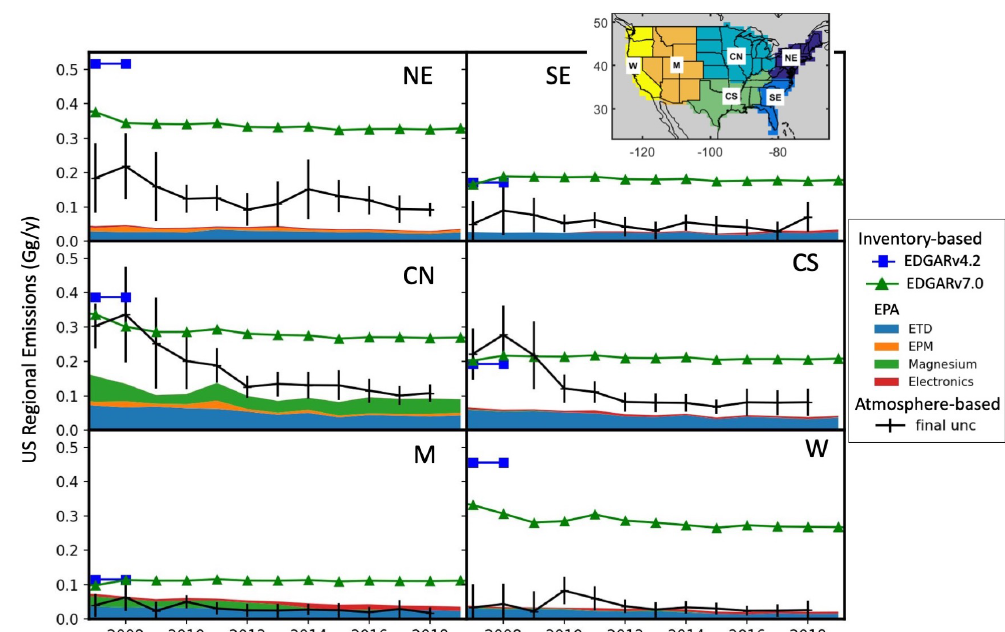
Figure 2. Regional SF 6 emissions over the United States, derived from atmospheric observations and reported by EPA’s GHGI and EDGAR (EDGARv4.2 and EDGARv7.0). EPA emissions are parsed out by sectors, i.e., electrical power transformation and distribution (ETD), elec- trical power manufacturing (EPM), magnesium production, and electronics, while EDGAR emissions are presented as totals. Atmosphere- based emission estimates (black lines) include uncertainties at a 95% confidence interval (vertical black